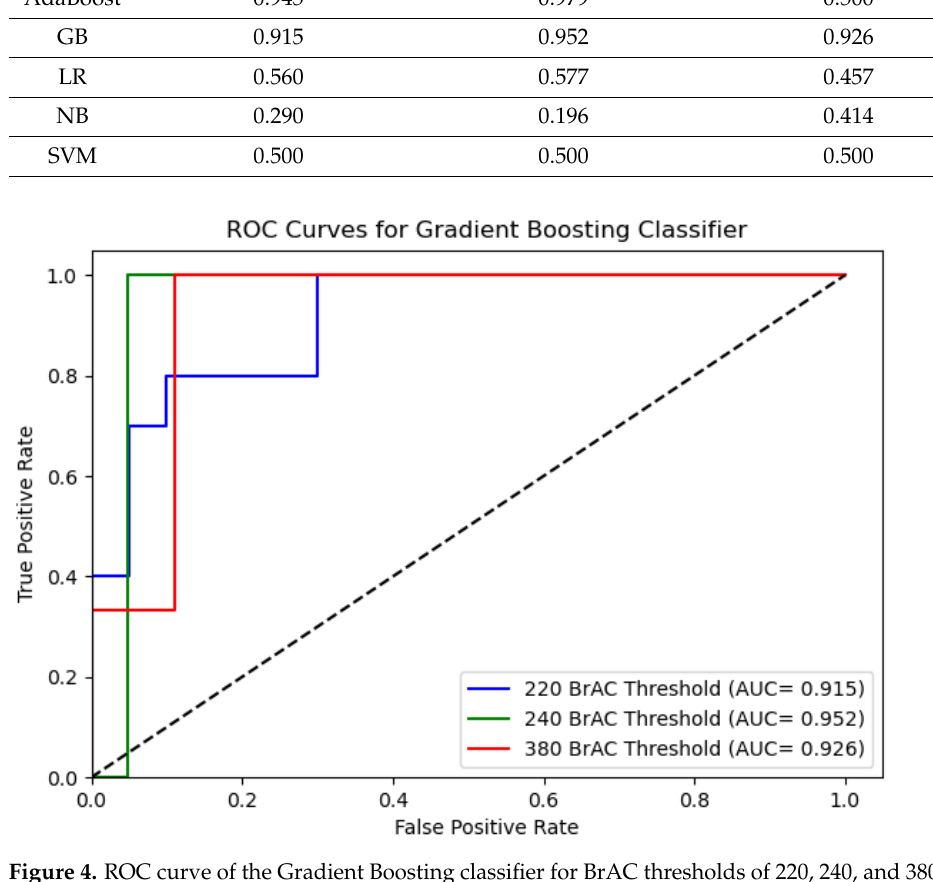
Figure 4. ROC curve of the Gradient Boosting classifier for BrAC thresholds of 220, 240, and 380 from data that was obtained from a smartphone and wrist-worn